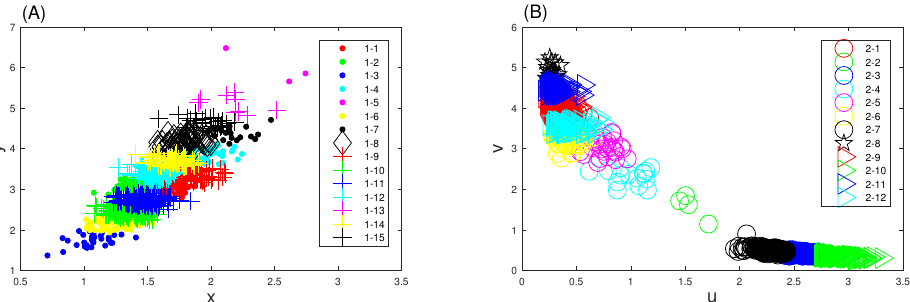
Figure 2. The clustering diagrams of the generated simulation data. ( A ) The 15 clusters of the simulations for the first test model (5). ( B ) The 12 clusters of the simulations for the second test system